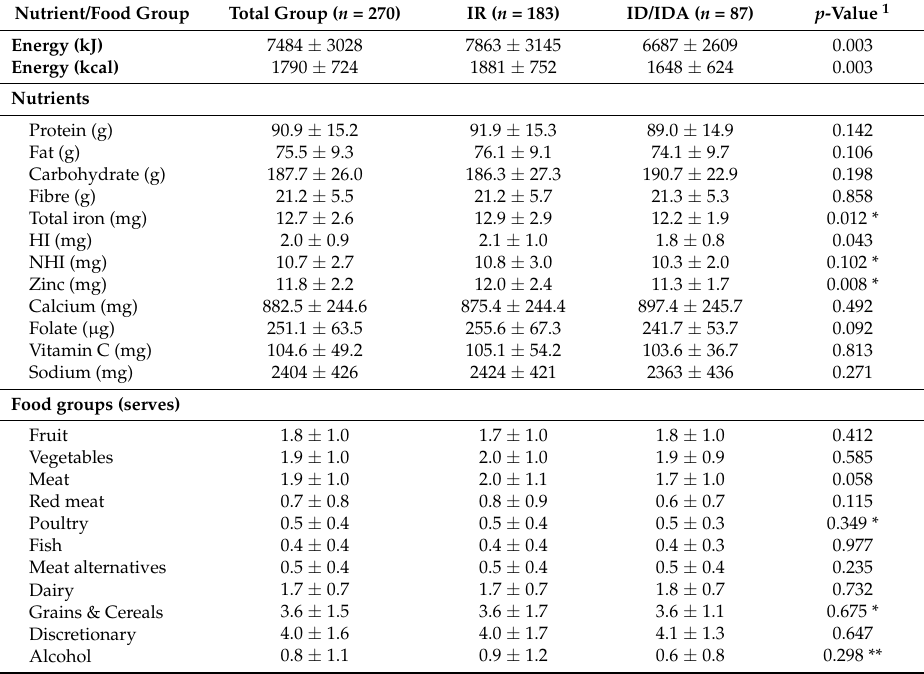
Table 2. Mean daily nutrient and food group intake